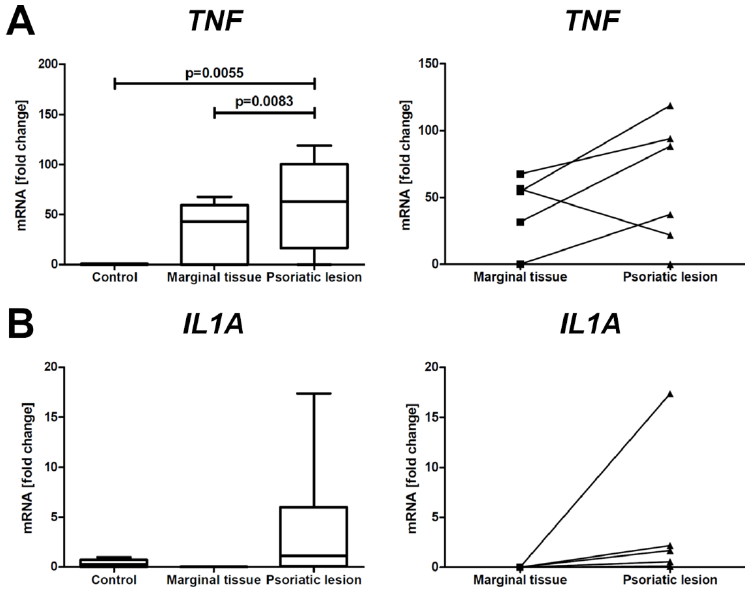
Figure 1. mRNA expression of pro-inflammatory genes ( TNF and IL1A ) in healthy skin, marginal tissue, and PsO lesions. The graphs on the left compare the expression levels of TNF ( A ) and IL1A ( B ) in PsO lesions and their marginal tissue (n = 6) with the skin of healthy individuals (n = 6). The graphs on the right show the paired gene expressions of TNF ( A ) and IL1A ( B ) in PsO skin lesions and marginal tissue from each individual patient (n = 6).